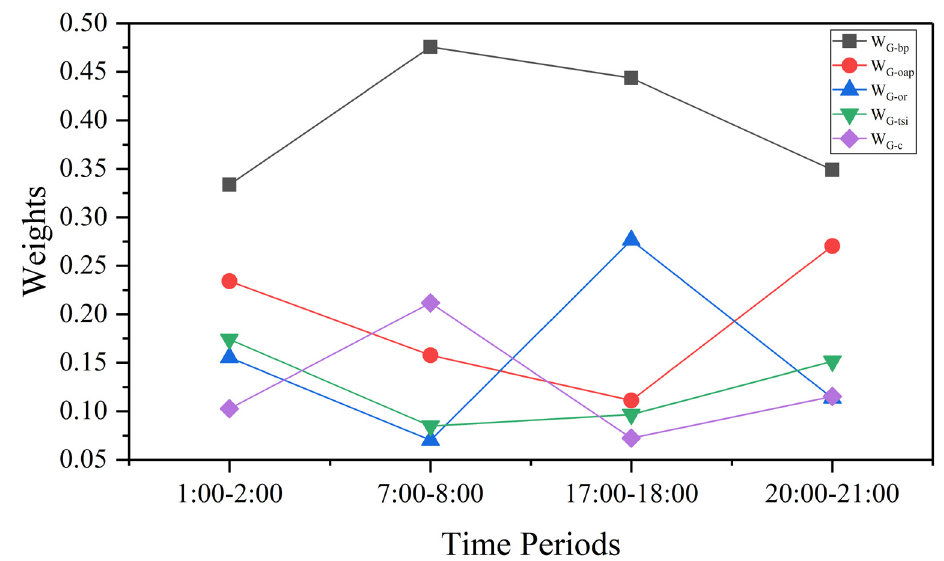
Figure 15. Time weights of each indicator. Table 6. Weighted grid value ranking for each time period(The bold part is the relevant indicators of the grid area that ranks first in the comprehensive hotspot during the period).